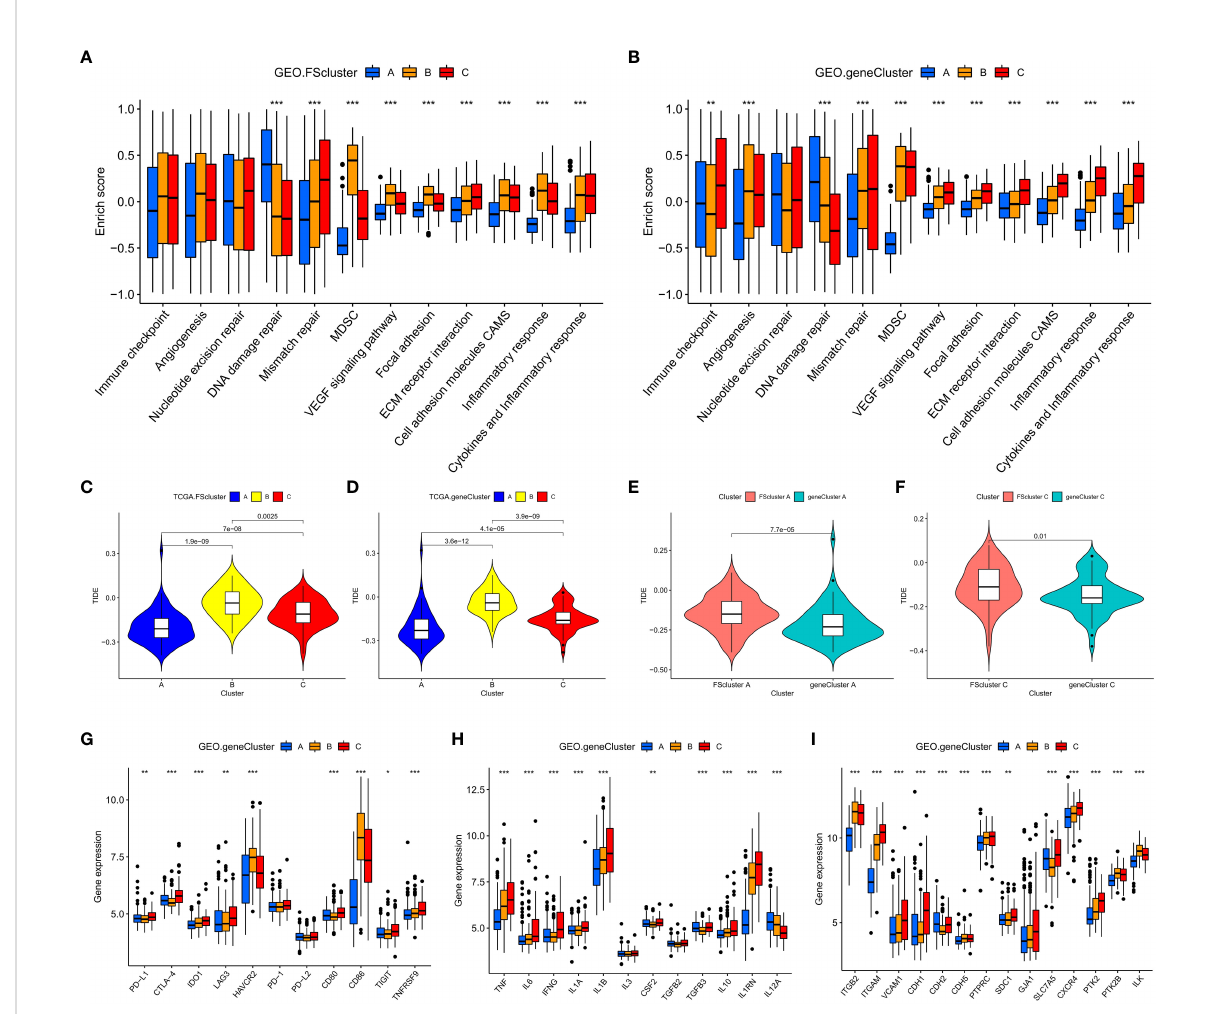
FIGURE 4 Analysis of TME characteristics associated with ferroptosis-related phenotypes. (A, B) Differences in pathway signatures related to tumor development and the in fi ltration level of MDSCs in the TME of ferroptosis-related molecular pattern and genomic subtype groups in the GEO cohort. (C – F) Differences in TIDE scores of ferroptosis-related molecular pattern and genomic subtype groups in the TCGA cohort. (G – I) Differences in gene signatures related to tumor development in the TME of ferroptosis-related molecular pattern and genomic subtype groups in the GEO cohort, G: Immune checkpoint-related genes, H: cytokines related to in fl ammation associated with AML, I: cell adhesion molecules associated with AML. Kruskal – Wallis test, *P < 0.05; **P < 0.01; ***P <